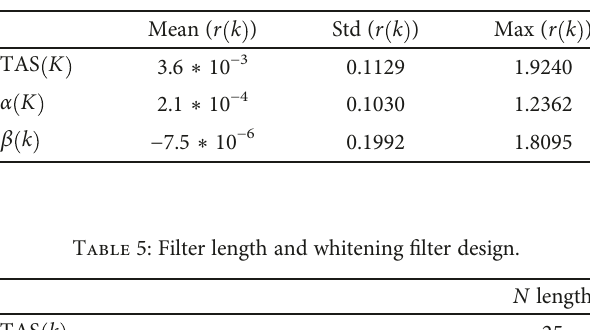
Table 4: Training performance results. Statistics of residual signals based on TR-FLIGHT-1 and TR-FLIGHT-2.